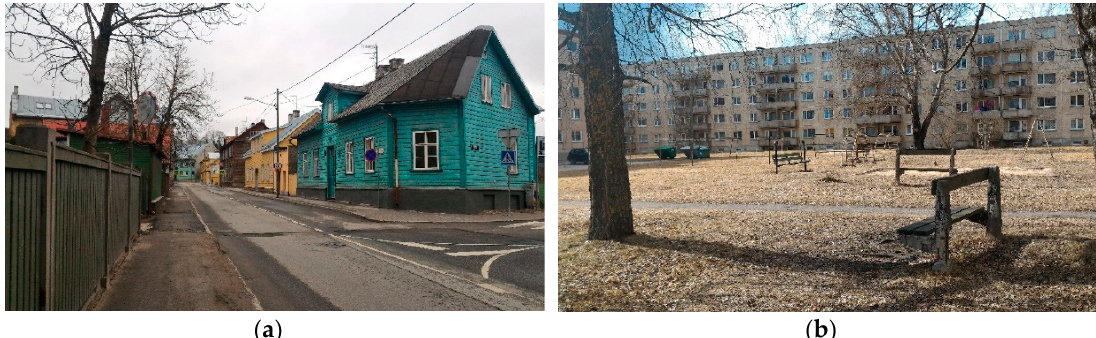
Figure 1. Single-family houses in the Supilinn district ( a ) and Soviet-era housing blocks in Annelinn district ( b ) in Tartu, C. Silva photo—all rights reserved.